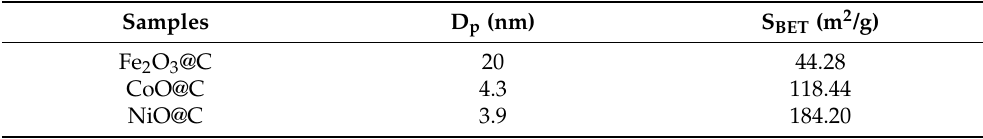
Table 1. Pore-structure characteristics of adsorbents.